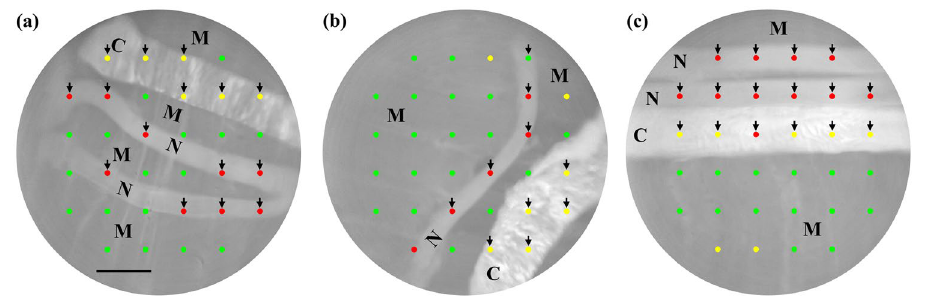
Figure 3. Representative results of tissue-type mapping overlaid with bright-field images. Colored circular spots exhibit Raman measurement points, that is, tissue-type discrimination points. At red, yellow, and green points, tissues are discriminated as peripheral nerve bundle, connective tissue, and skeletal muscle tissue, respectively. The scale bar is 1 mm. N, C and M denote myelinated nerve bundle, connective tissue and skeletal muscle tissue,